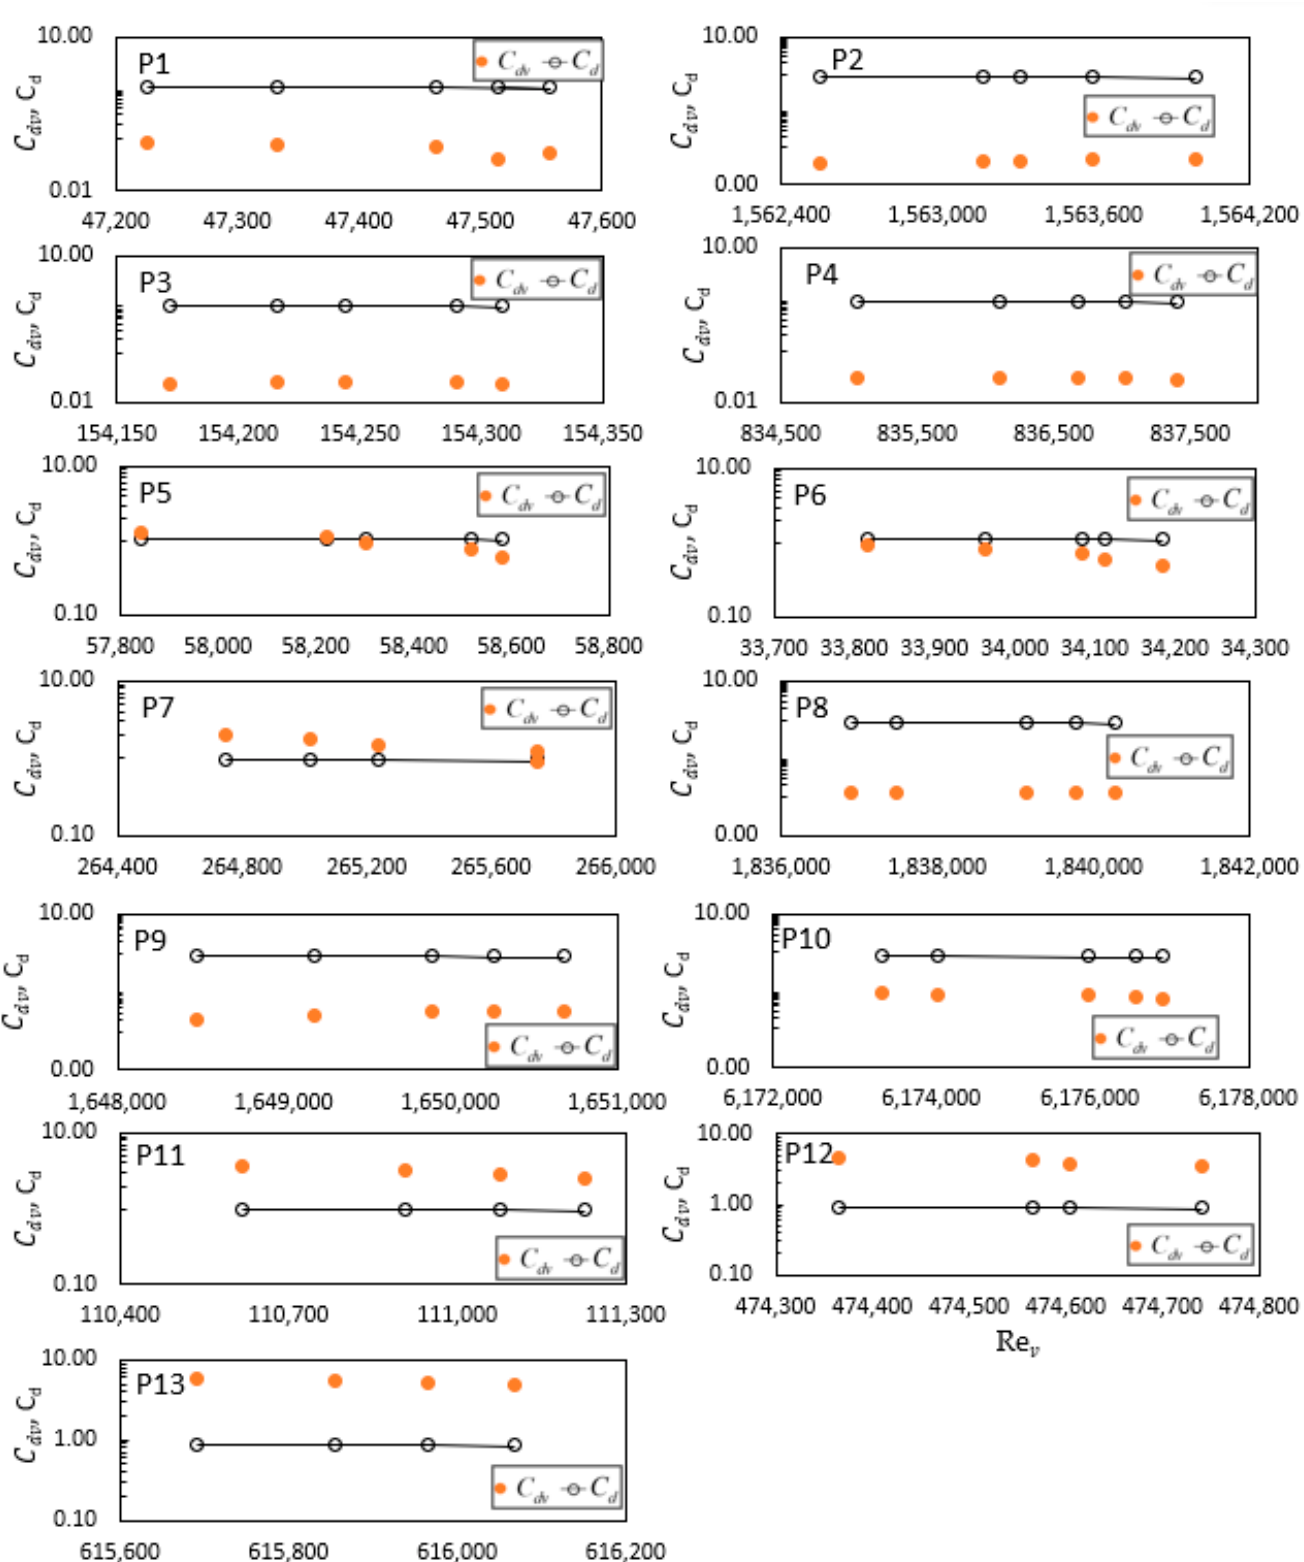
and 𝐶 (cid:3031)(cid:3049)